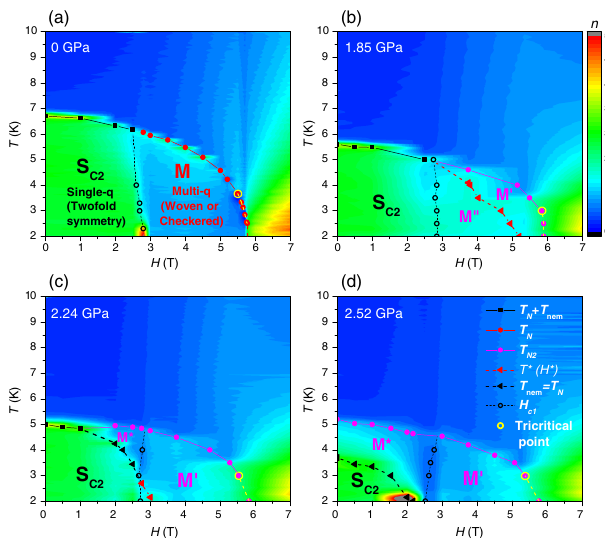
FIG. 5. False-color map of the effective resistivity exponent n in the H - T phase diagram at (a) 0 GPa, (b) 1.85 GPa, (c) 2.24 GPa, and (d) 2.52 GPa. The green region denotes the single- q stripe phase (S ), and the light-blue region denotes the C 2 other possible AFM phases (M, M ’ , M ” , and